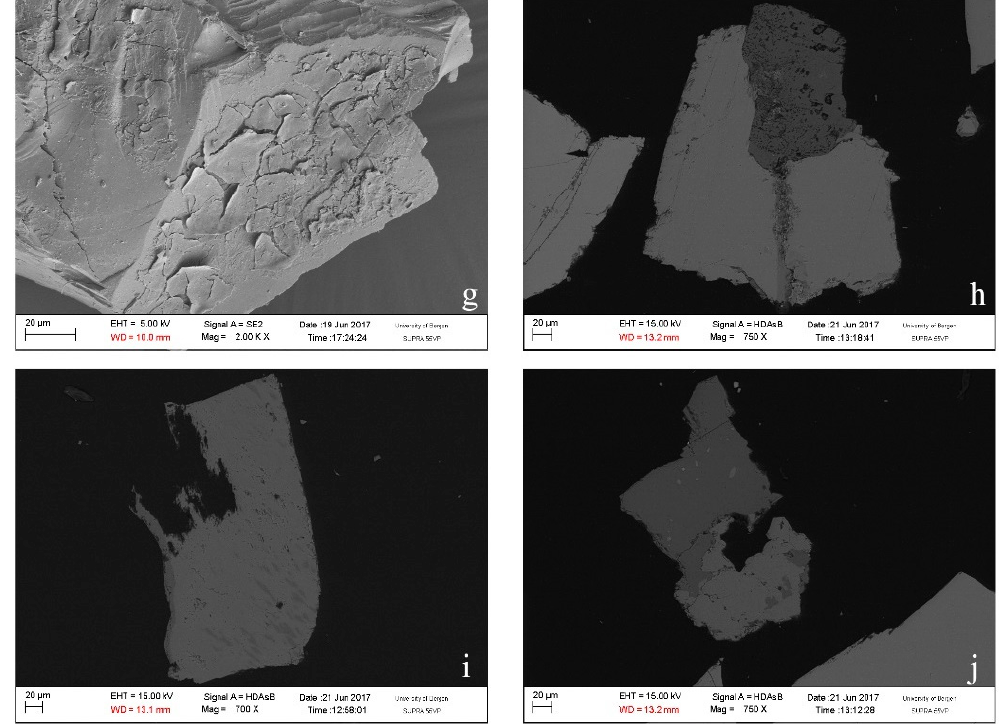
Figure 4. SEM micrographs of unreacted ( a – c ) and reacted ( d – j ) nepheline syenite grains. Both loose grains ( a , d – g ) and polished sections ( b , c , h – j ) are shown. Preferential dissolution along exsolution lamellae is shown in ( d , e ). Images ( d – f ) show crystallographically controlled roughening at mineral surfaces. Thin layers formed by precipitation or leaching are shown in ( g ). In images ( h – j ), note the roughening of grain surfaces, and the removal of mineral phases from grains, resulting in cavities in these grains.